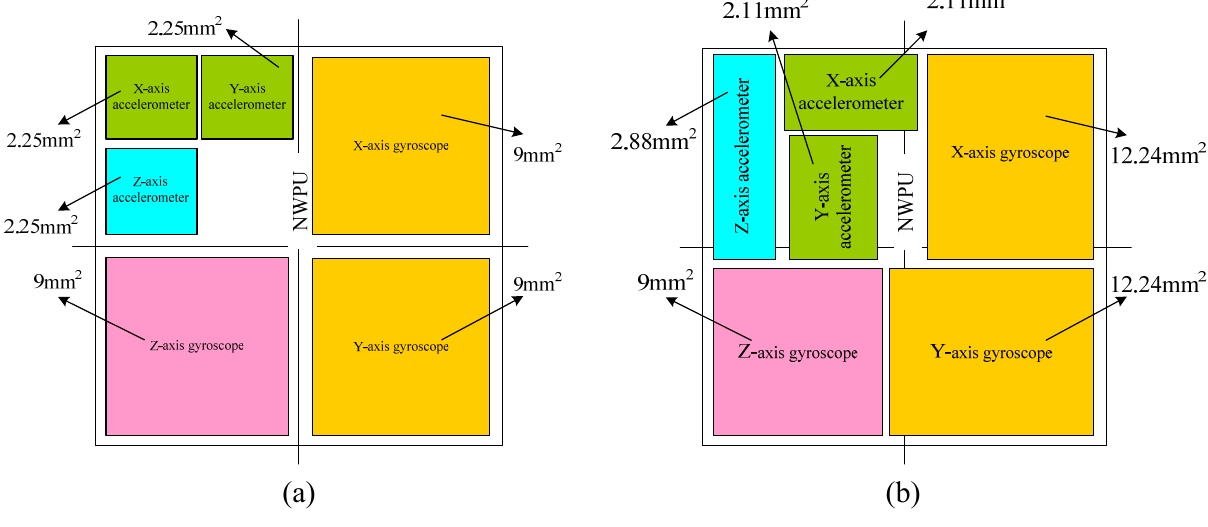
Figure 9. Layout configuration of the mechanical sensing element chip. (a) The layout configuration after global optimization. (b) The final layout configuration after device